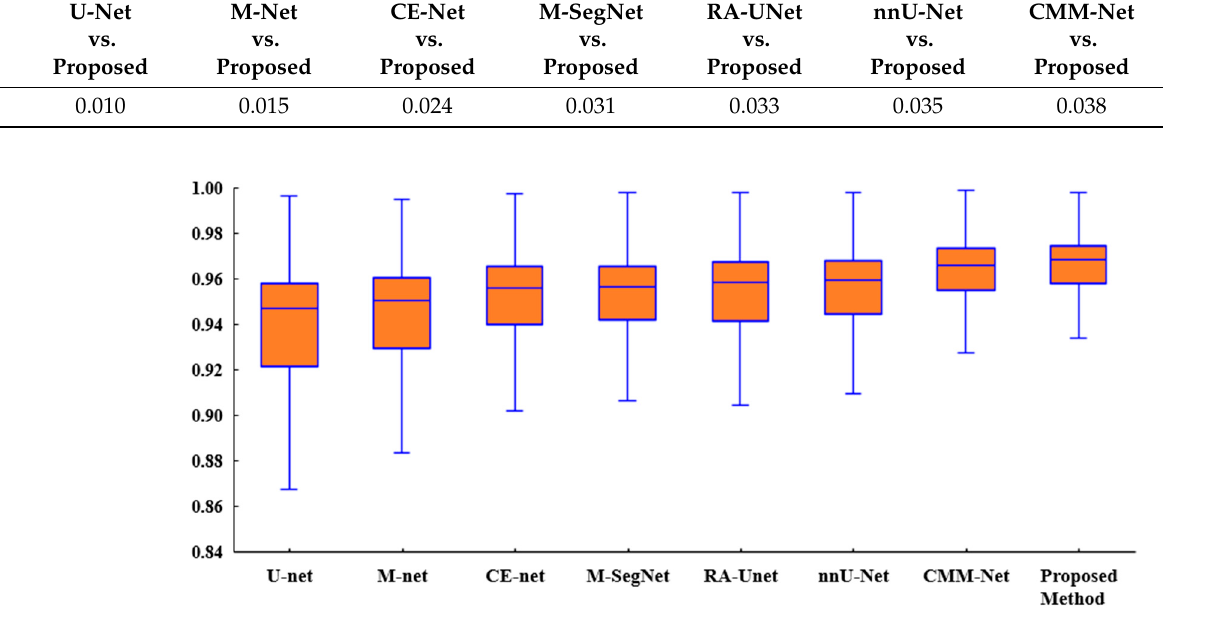
Figure 6. Box plot of the accuracies of the proposed method and existing methods for the UFBA-UESC dental dataset.